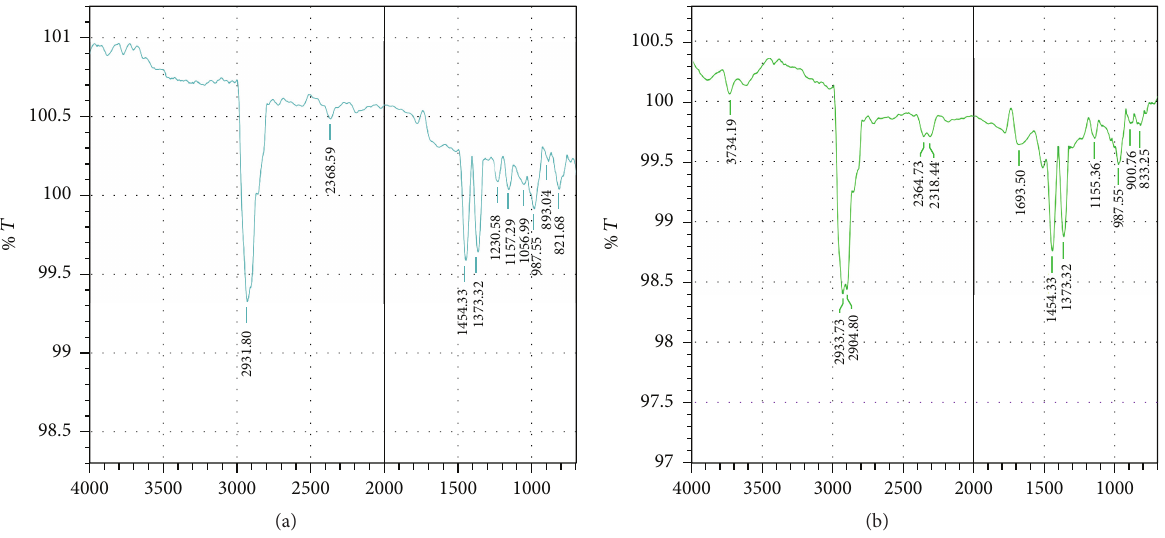
Figure 10: (a) FTIR spectrum of 15% NaOH treated BF/PP and (b) 15% KMnO 4 treated BBF/PP